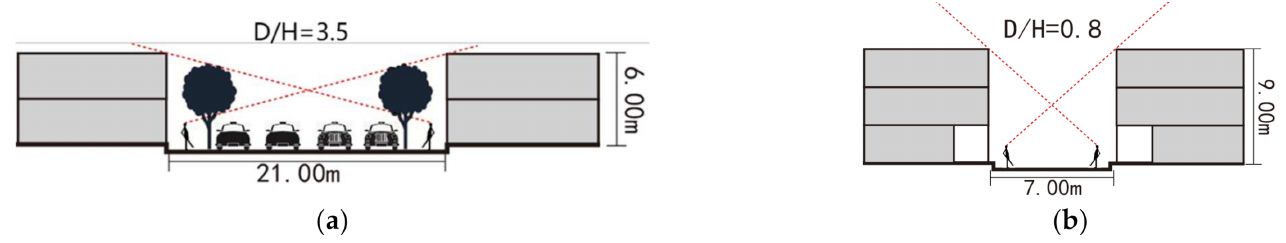
Figure 7. Comparison of streets with different D/H ratios and vitalities: ( a ) The street with high D/H ratio and low vitality (Nanshan Road); ( b ) the street with low D/H ratio and high vitality (Amoy YatSen